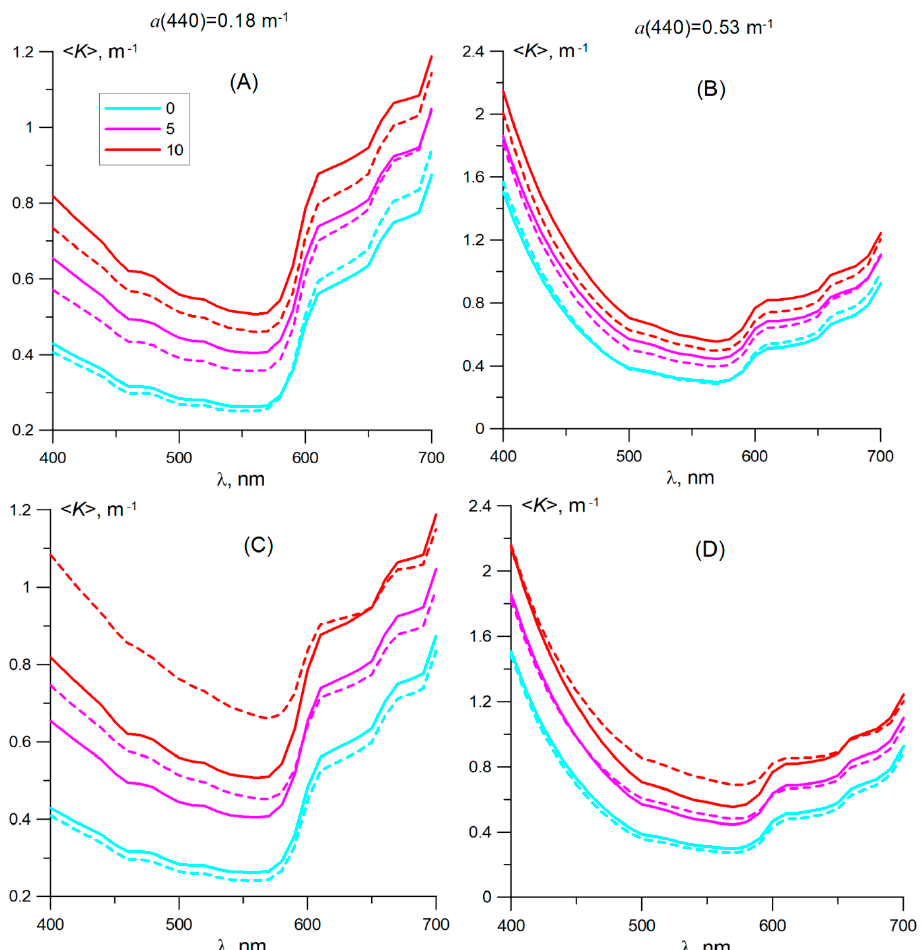
Figure 17. Spectral values of the diffuse attenuation coefficient < K > depending on the N coc (10 6 cell/L), clear sky, θ 0 = 60°. Solid lines, numerical simulation; dashed curves, the approximate formulas. A, C, ICAM absorption a (440) = 0.18 m -1 ; B, D, the modeling absorption a (440) = 0.53 m -1 . A, B, Equation (12); C, D, Equation (13).